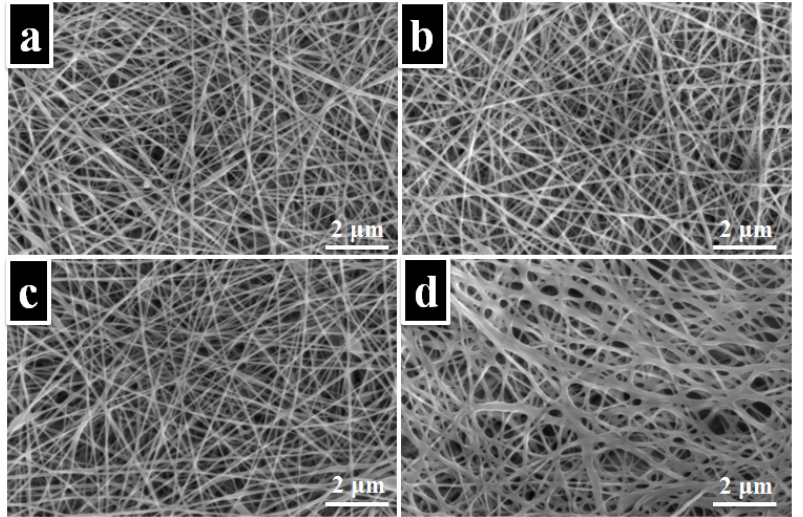
Figure 3. SEM images for the electrospun membranes of PVA ( a ), PVA– Thymus vulgaris ( b ), PVA– Salvia officinalis folium ( c ), and PVA– Hyperici herba ( d ).